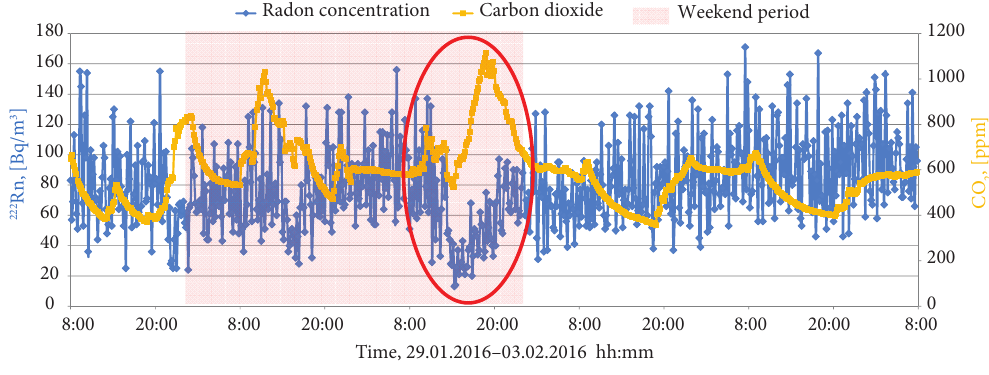
Figure 7. Indoor radon and carbon-dioxide concentration in 2016 winter at Gö2 house in case of 5 day measurement